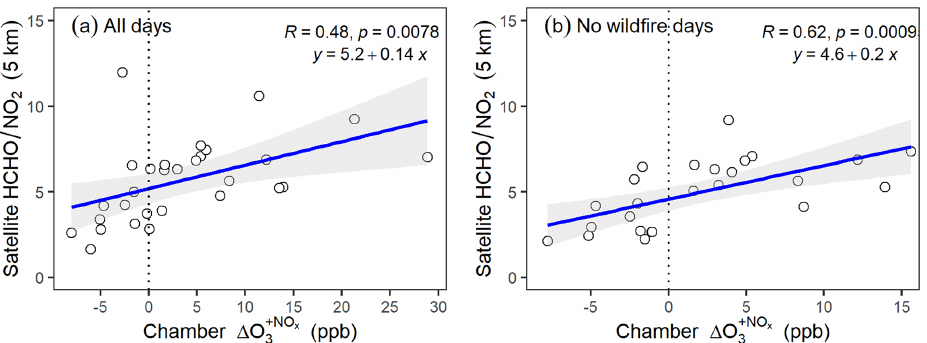
Figure 8. Ordinary least squares (OLS) regression between weekly-averaged TROPOMI HCHO / NO 2 at 5km circular buffers and the + NO x weekly-averaged (cid:49) O from ground-based measurement. The shaded area shows the 95% confidence interval of the mean response of 3 the predicted